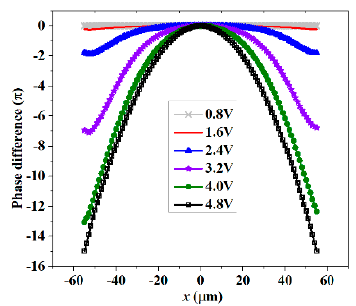
Figure 7. Simulated relative phase profiles across the LC microlens with different operating voltages.